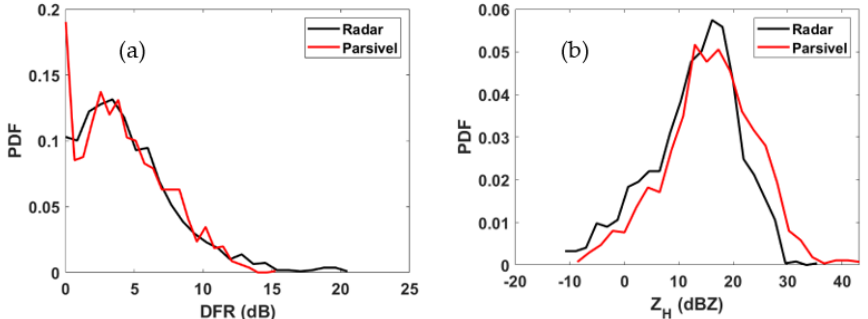
Figure 6. Probability density of DFR ( a ) and Z ( b ) from the observations of the D3R radar and calculated from PSD measurements.